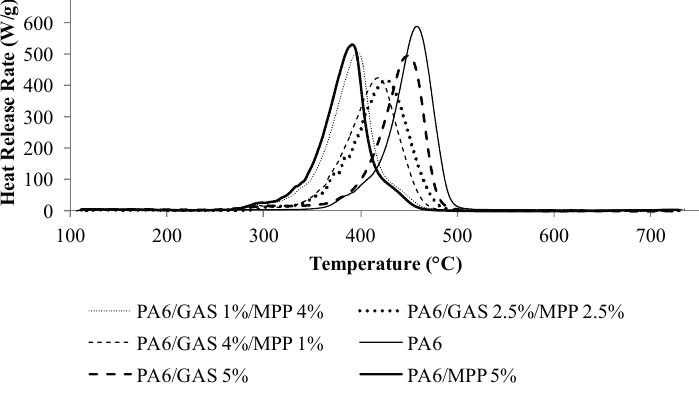
Figure 1. Heat release rate (HRR) curves vs. temperature obtained with pyrolysis combustion flow calorimetry (MCC) of PA6 and PA6/GAS/MPP